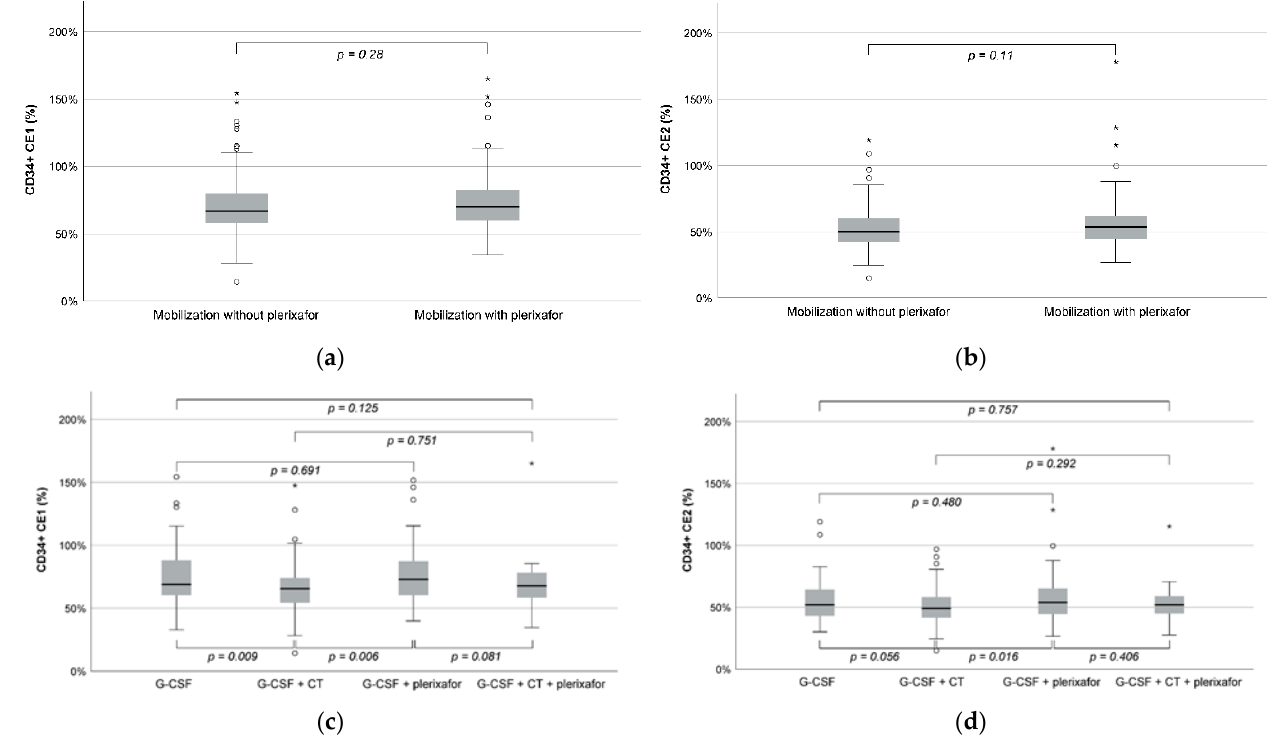
Figure 2. Distribution of individual CE1 ( a , c ) and CE2 ( b , d ) values by mobilization regimen ( a , b ) and subgroup ( c , d ). CE, collection efficiency; Q1, first quartile; Q3, third quartile; G-CSF, granulocyte colony-stimulating factor; CT, chemotherapy. Notes: Error bars represent 95% confidence intervals. Outliers ( ◦ ) are defined as values lower than Q1-1.5*interquartile range or higher than Q3 + 1.5*in- terquartile range. Extreme outliers (*) are defined as values lower than Q1-3*interquartile range or higher than Q3 + 3*interquartile